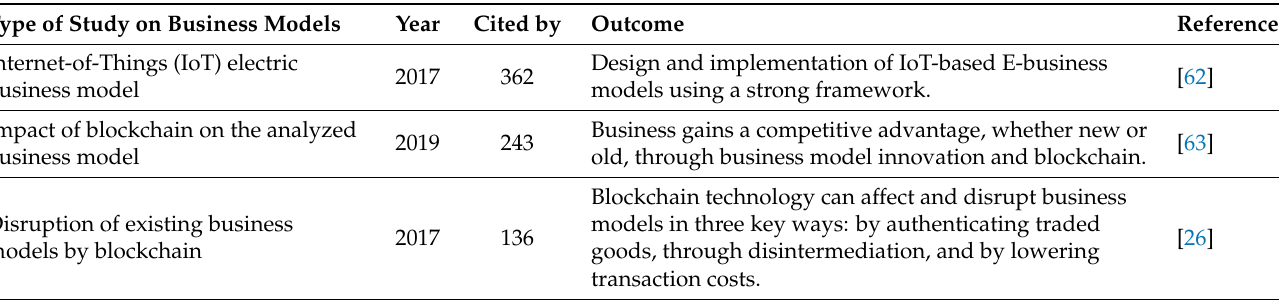
Table 1. The most-cited articles (2012–2022) on business models and their